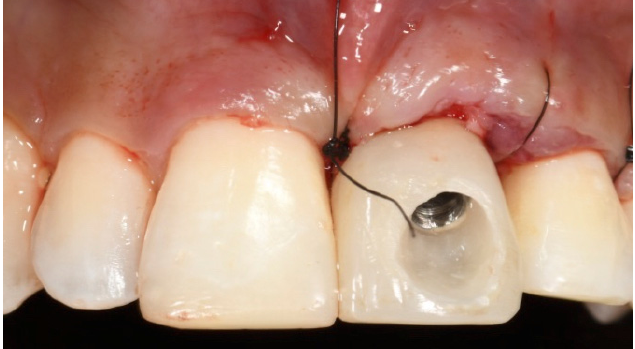
Figure 15. Flaps coronally advanced and sutured along with single stitches using a non-resorbable suture.